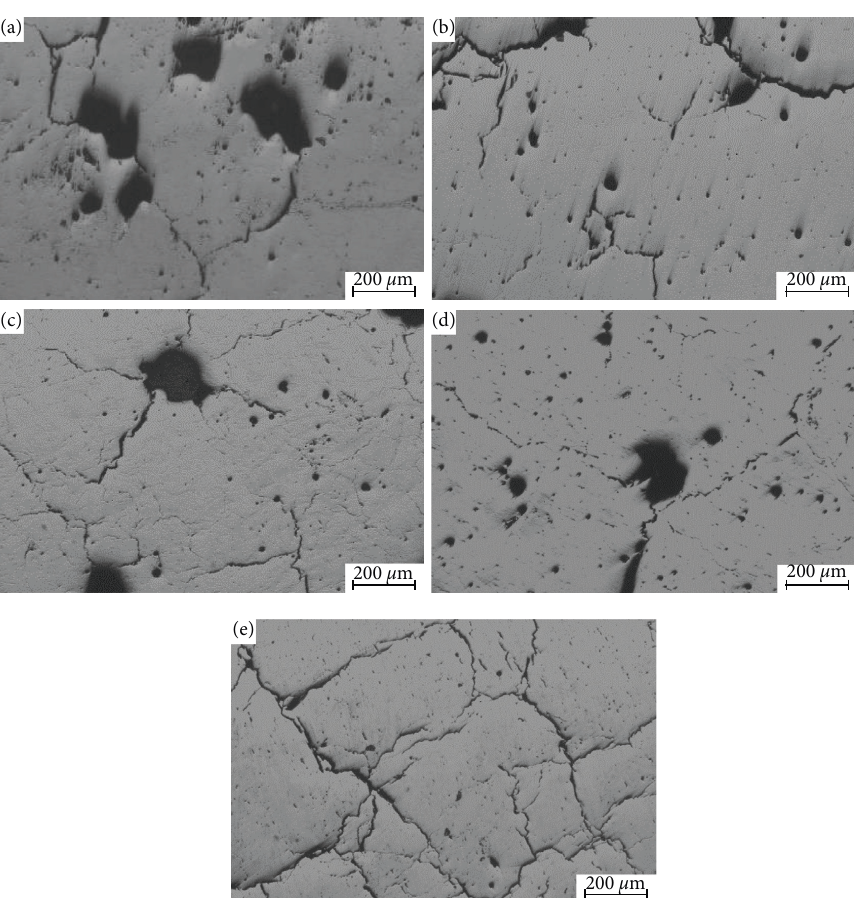
Figure 3: Schematic diagram of the micromorphology of 1-1 under different printing powers: (a) parameter combination 1, (b) parameter combination 2, (c) parameter combination 3, (d) parameter combination 4, and (e) parameter combination 5. Table 4: Molybdenum silicon boron element content and theoretical density after ICP measurement. Serial number Mo (at. %) Si (at.